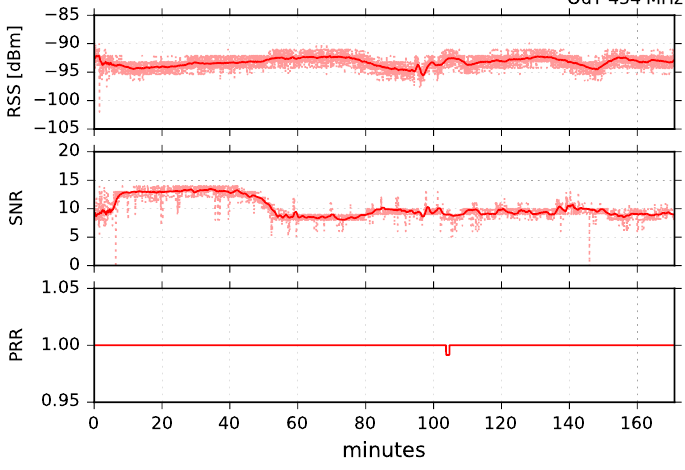
Figure 17. RSS, SNR, and PRR for ODT at 434MHz in LOS channel conditions for BW = 125kHz, SF = 10, and CR =